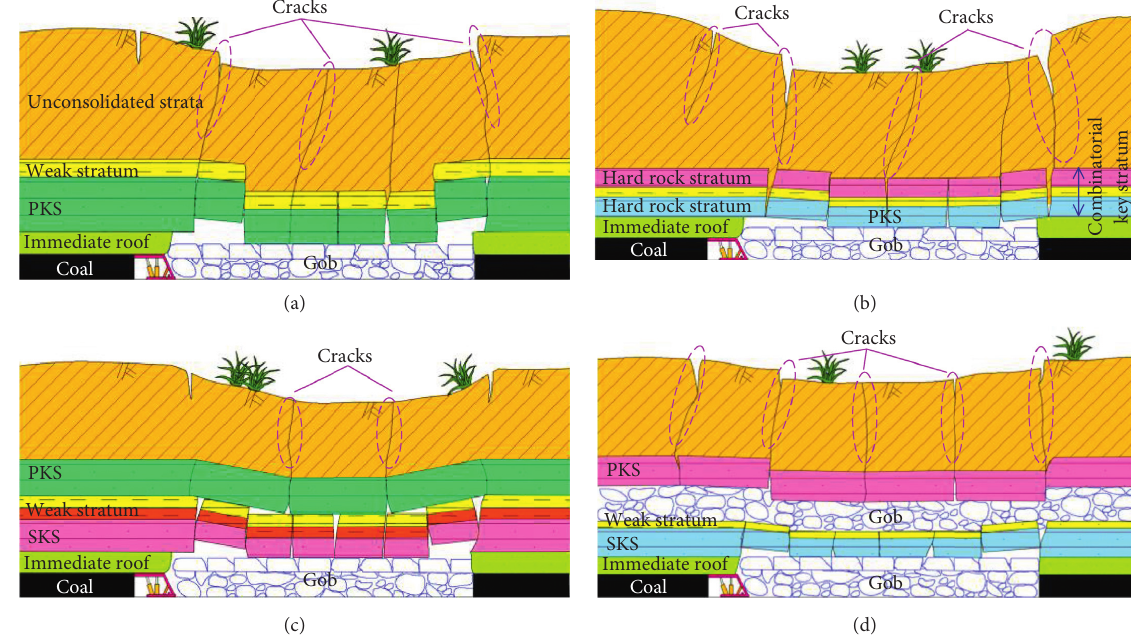
Figure 2: Types of key stratum structures in shallow seams: (a) thick and hard single-key stratum structure; (b) single-key stratum structure of a compound group; (c) multikey strata structure; (d) single-key stratum structure of an over-seam extracted